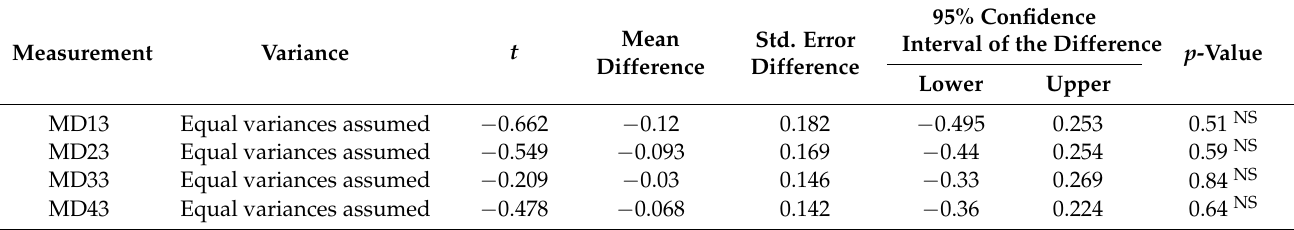
Table 2. The mean difference between two mean using independent sample t-test or the mesiodistal width of maxillary and mandibular canine.